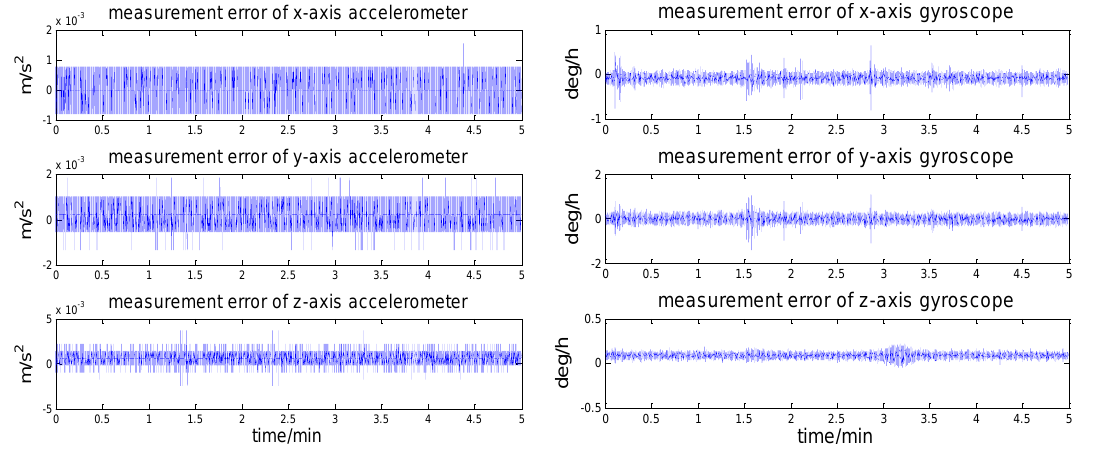
Figure 5. Accelerometer and gyro errors.